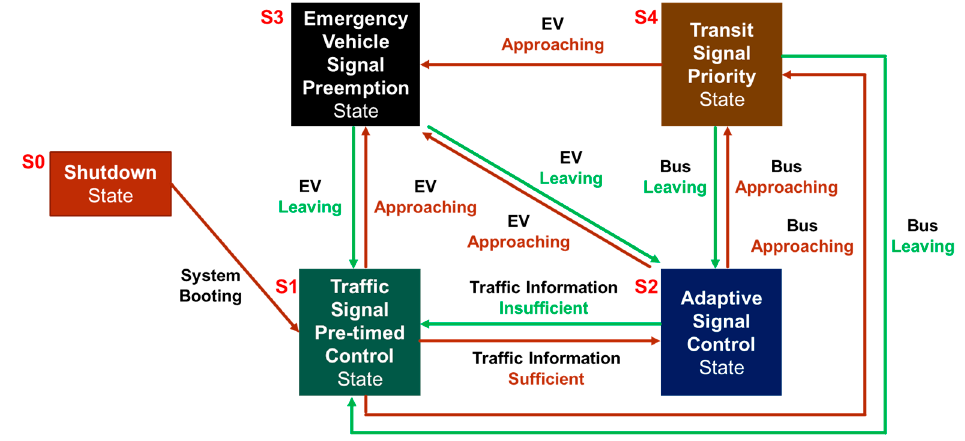
Figure 3. Smart traffic signal controller’s state transition diagram. Figure 3. Smart tra ffi c signal controller’s state transition